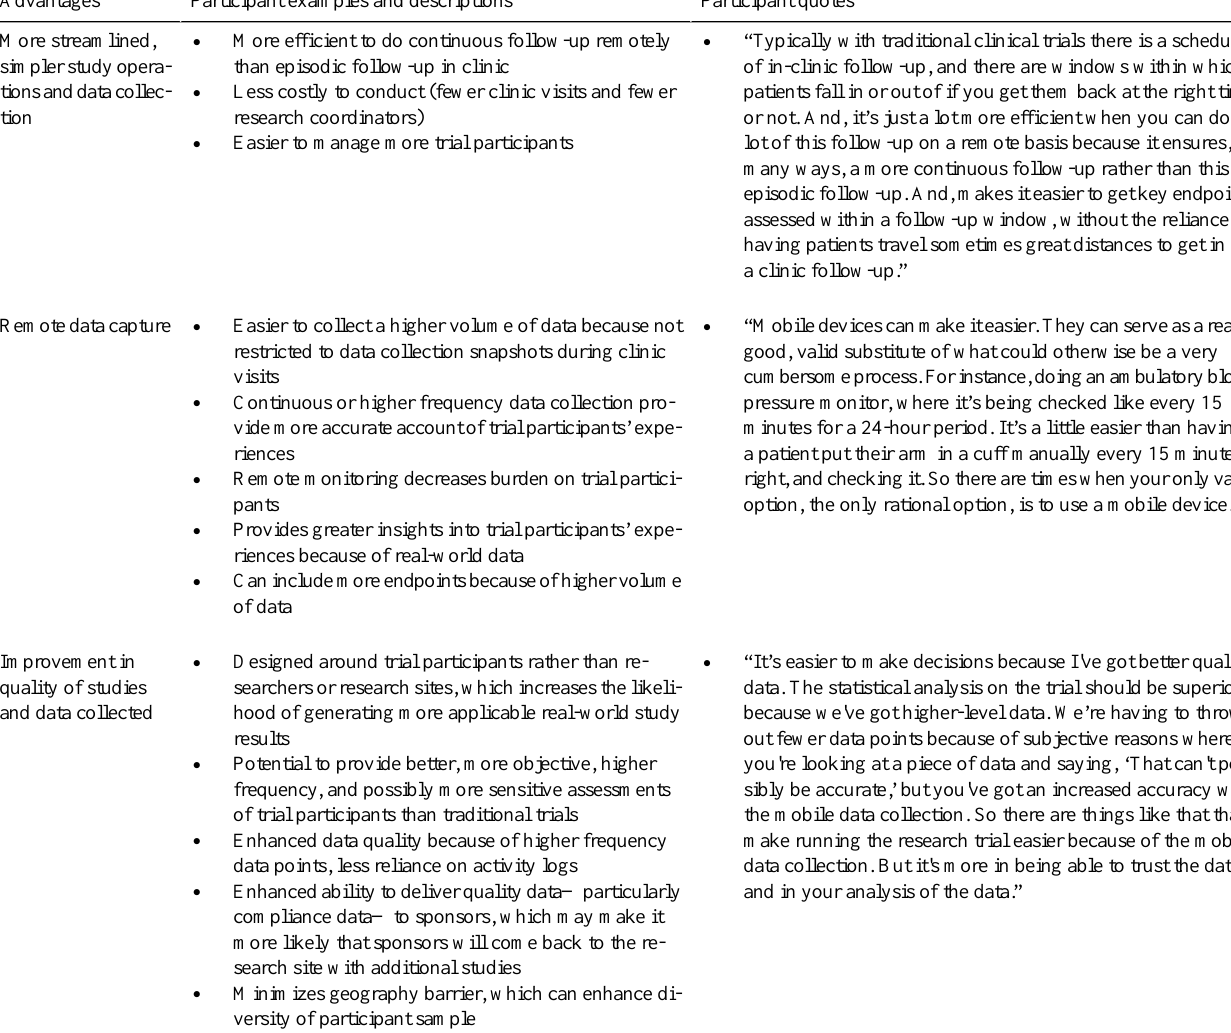
Participant quotesParticipant examples and